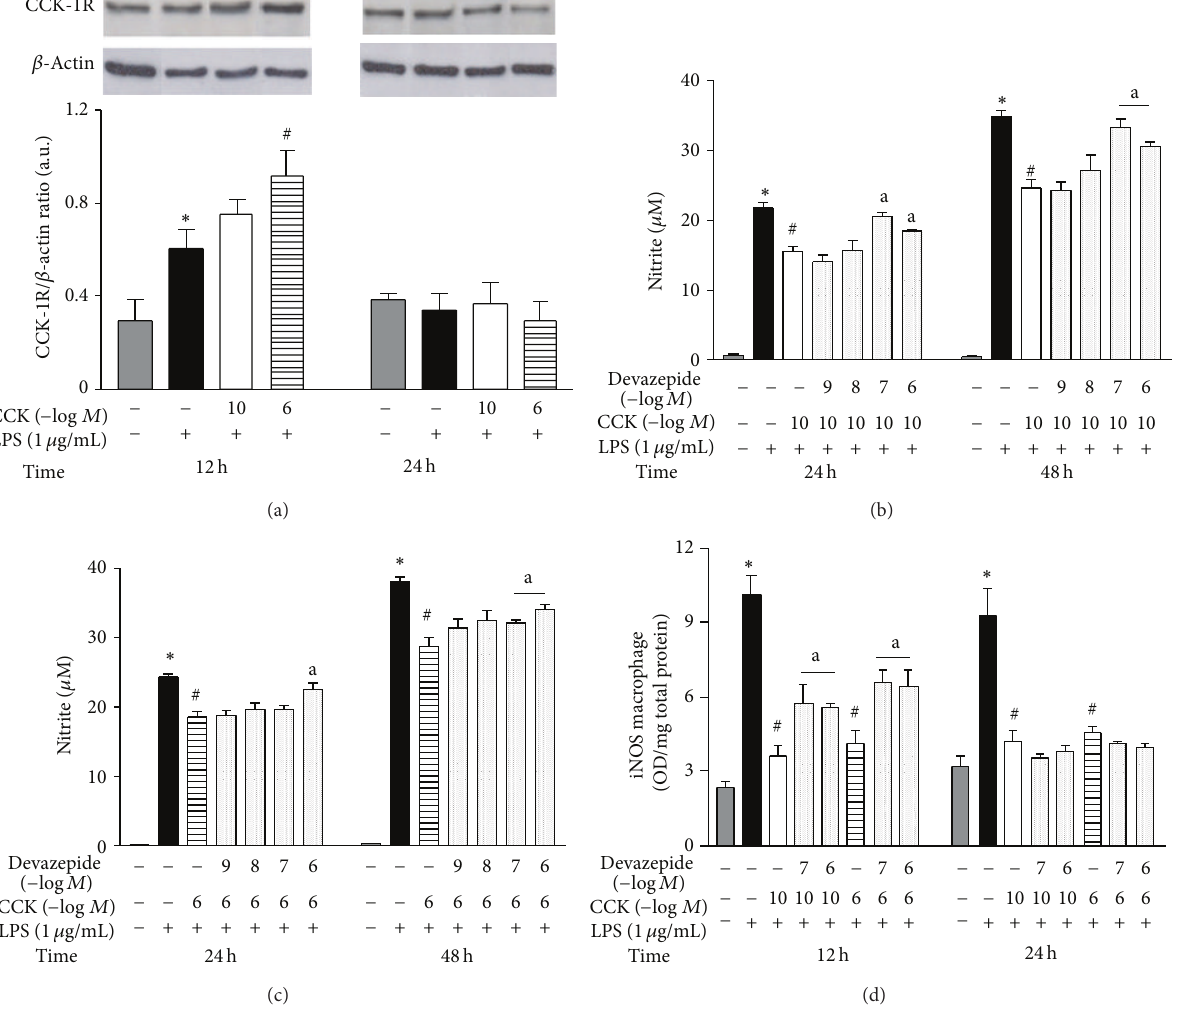
Figure 6: CCK attenuates LPS-induced iNOS expression interacting predominantly through CCK-1R by peritoneal macrophages. The macrophage culture was pretreated with CCK (10 −10 or 10 −6 M) for 30 min before the addition of LPS (1 𝜇 g/mL) to the culture medium (time zero). At the indicated time-points, whole cell lysates were obtained for analysis of CCK-Rs expression by western blot. (a) Representative immunoblots with densitometry values were shown for CCK-1R/ 𝛽 -actin ratio. The 𝛽 -actin levels were used as an internal control. The relevance of CCK-1R subtype was pharmacologically tested, incubating macrophage culture with selective antagonist [devazepide (CCK- 1R antagonist; 10 −9 –10 −6 M)] for 30 min before the addition of CCK at 10 −10 or 10 −6 M. Thirty minutes later, cells were stimulated by LPS. The culture supernatant was collected for nitrite quantification by Griess method (b and c) and the iNOS synthesis was determined in cell lysates by ELISA (d). Data is a representative of three independent experiments with similar results. Values are expressed as means ± S.E.M. 𝑛 = 4–12 samples per group. ∗ 𝑃 < 0.05 versus saline, # 𝑃 < 0.05 versus LPS, and 𝑎 𝑃 < 0.05 versus respective CCK